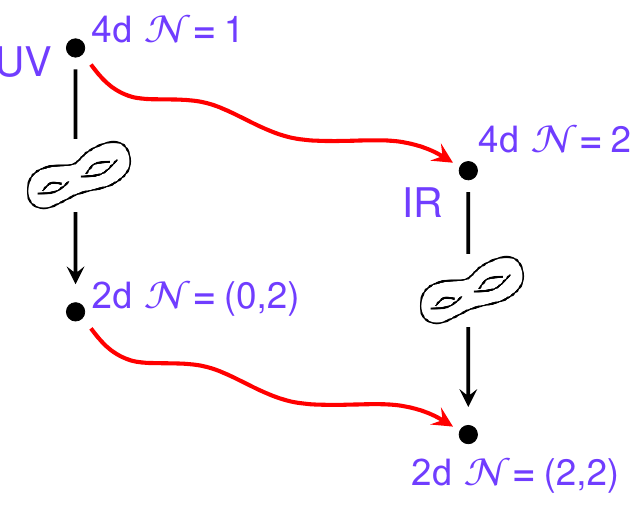
Figure 6 . Topological reduction of the endpoints of the four-dimensional RG (cid:13)ow from a UV theory with N = 1 supersymmetry to an IR theory with N = 2 supersymmetry. When the diagram commutes, 2d N = (2 ; 2) theory M ( F g ) can be identi(cid:12)ed by studying 2d RG